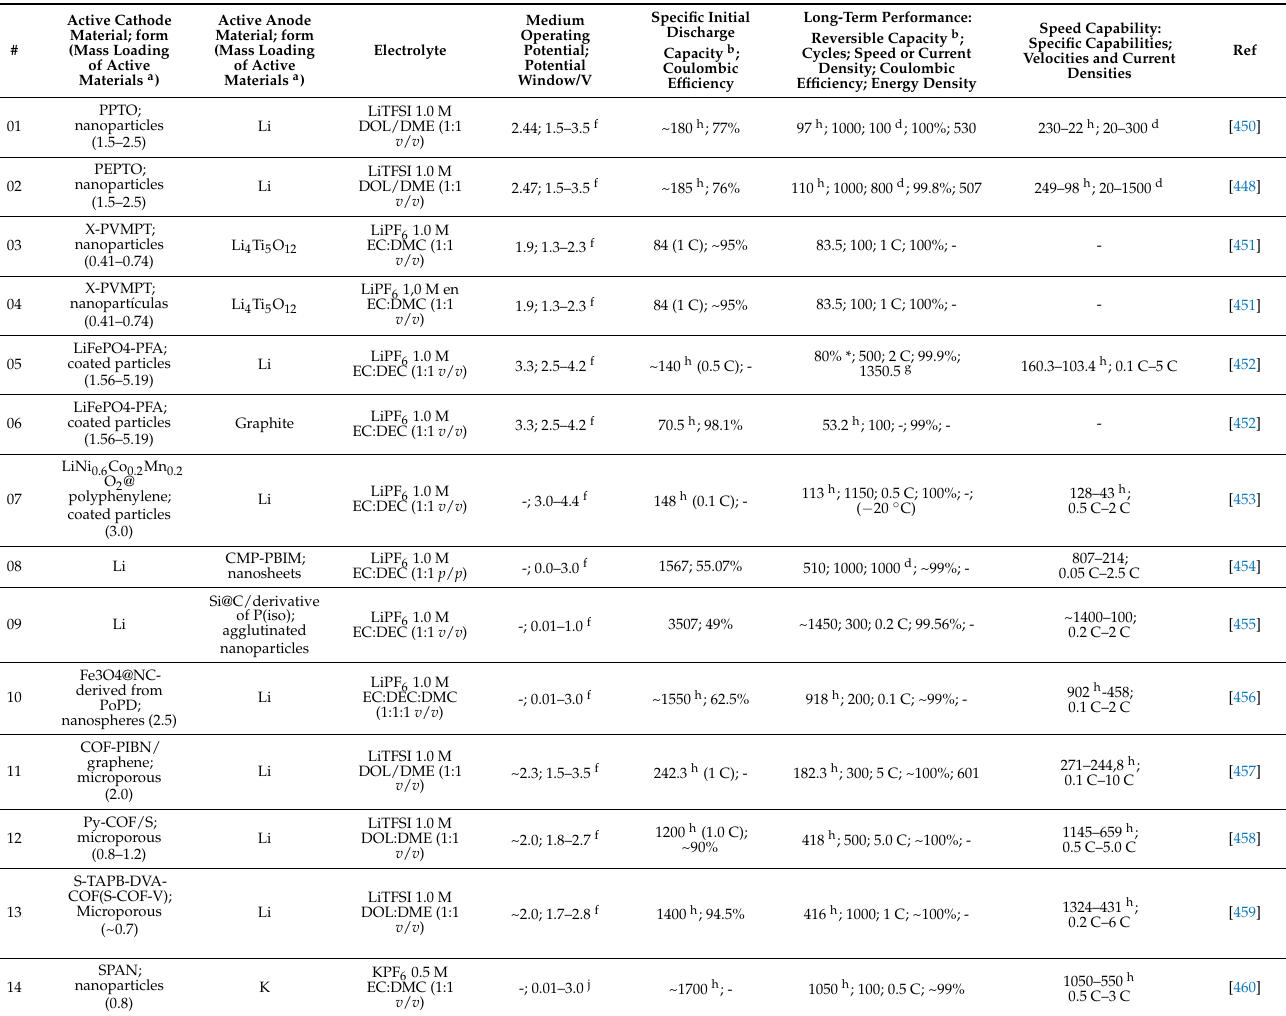
Table 9. Other polymeric nanostructures are evaluated for rechargeable battery electrodes, with their performance